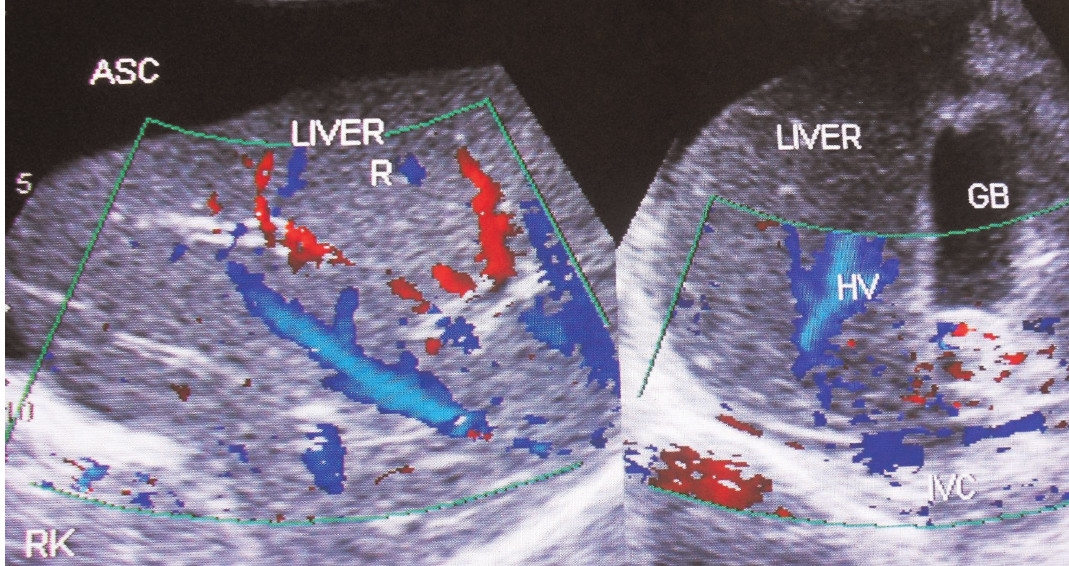
Figure 6. Ultrasonography and color Doppler of a patient with ascites due to HVCS. IVC shows stenosis at cavo-atrial junction with distal segment dilated. IVC is fi lled with organized thrombus. There is obstruction to blood fl ow at the hepatic vein outlets. Note thrombosis of medium-sized tributaries of right hepatic vein. GB, gall bladder; HV, hepatic vein; RHV, right hepatic vein. (Copyright: Santosh Man